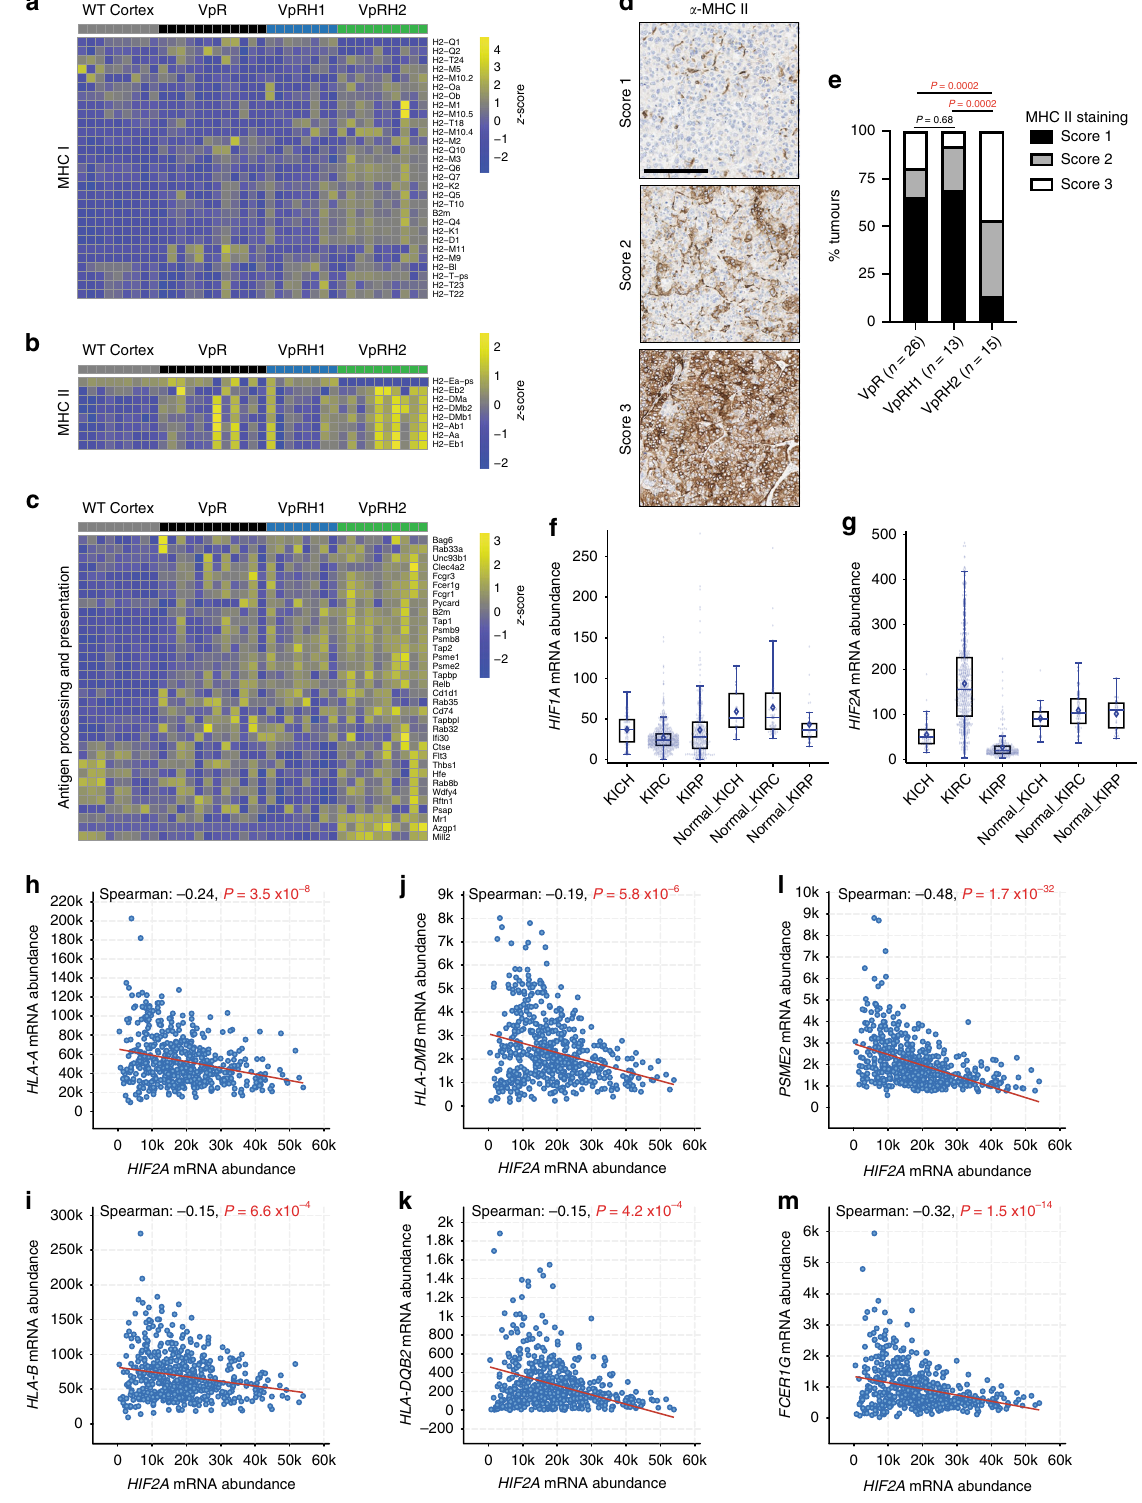
results of the bioinformatic immune cell deconvolutions for B cells. In contrast to the relatively low numbers of tumour- in fi ltrating lymphocytes, myeloid lineage cells were much more abundant within tumours. CD68 positive monocytes/macro- phages (Fig. 6i), F4/80 positive macrophages (Fig. 6j), and Ly-6G- labelled granulocytes/neutrophils (Fig. 6k) were highly